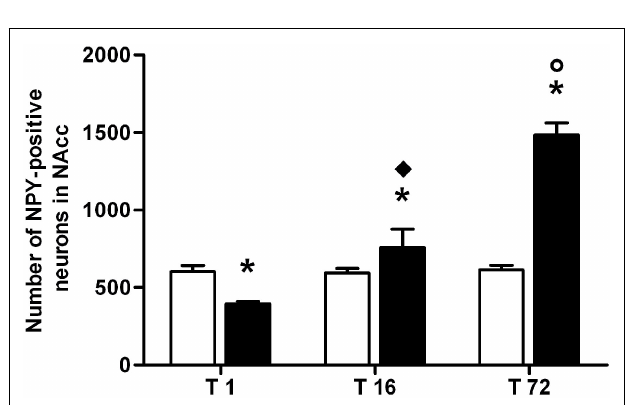
FIGURE 6 |Average number of neuropeptideY (NPY)-positive neurons detected in the nucleus accumbens (NAcc) during acetaldehyde intoxication and withdrawal . Each value represents the mean ± S.D. of 12 sections for each experimental condition. ( (cid:3) ) CTR, ( (cid:4) ) ACD. * p < 0.001 vs CTR, (cid:7) p < 0.001 vsT1, (cid:13) p < 0.001 vsT16.